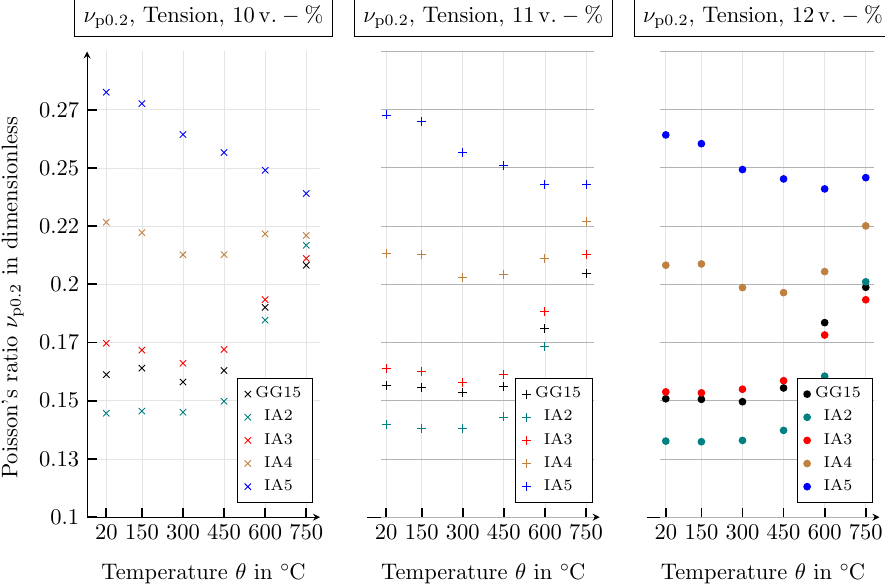
Figure 25. Poisson’s ratios of all graphite classes with graphite flake volume fractions of 10, 11 and 12v. %, evaluated for the temperatures 20, 150, 300, 450, 600 and 750°C, at a tensile strain of −